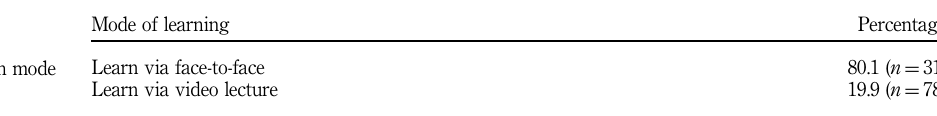
Table VI. Percentage on mode of